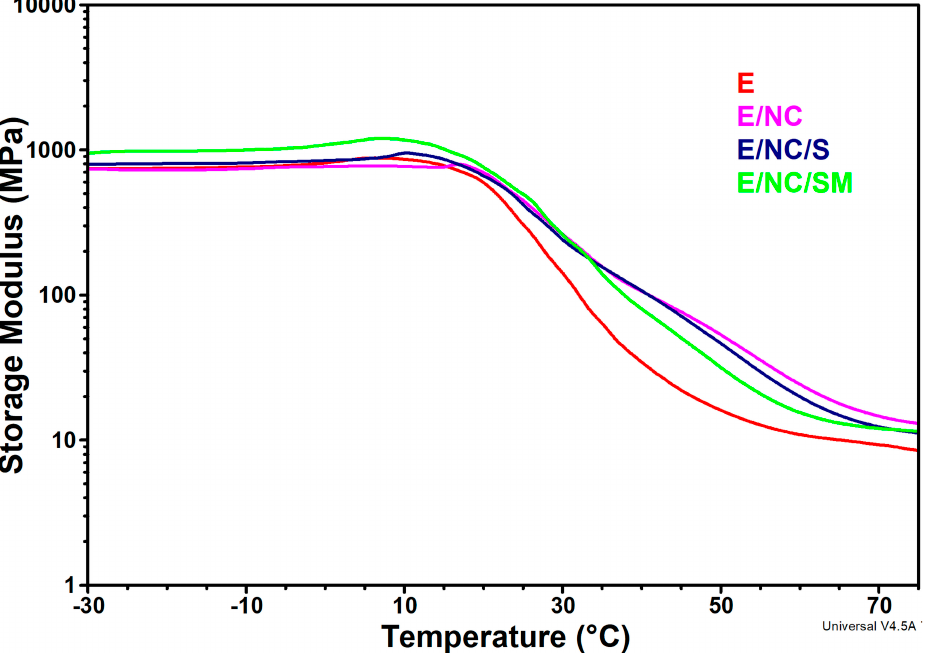
Figure 5. DMA storage modulus (E’) for the neat epoxy system and epoxy nanocomposites. As indicated in Table 2, in the glassy domain ( E ’ − 25°C and E ’ 0°C ), the lowest E’ was